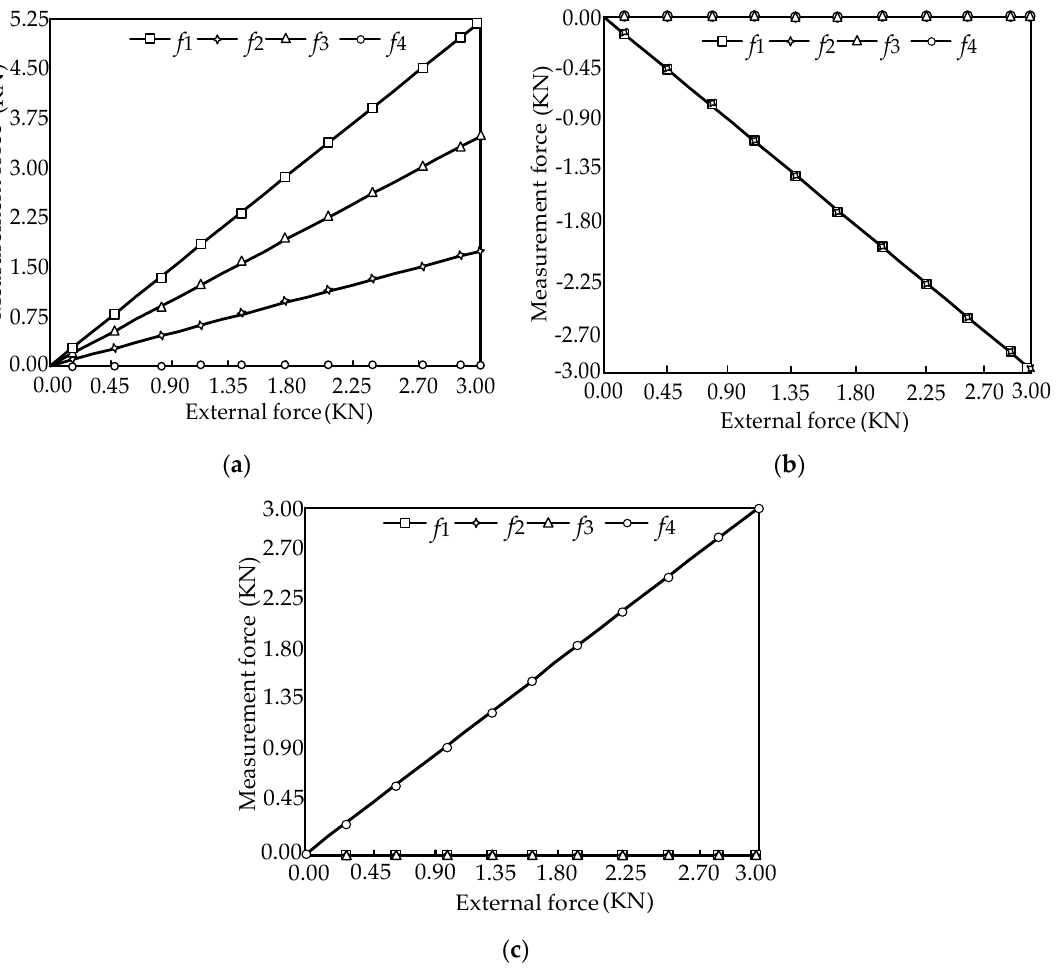
Figure 12. Force diagram of the sensor. ( a ) The relationships between the measurement forces f i ( i = 1, 2, 3, 4) and the external force component F X ; ( b ) The relationships between the measurement forces f i ( i = 1, 2, 3, 4) and the external force component F Y ; ( c ) The relationships between the measurement forces f i ( i = 1, 2, 3, 4) and the external force component F Z .